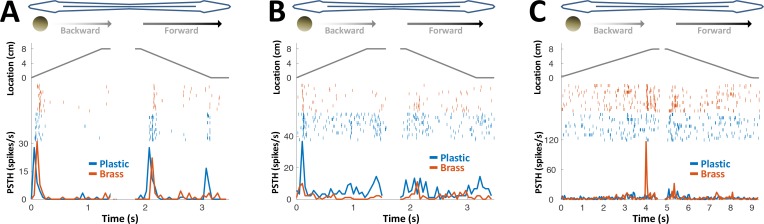
PG response to conductive/non-conductive objects.(A–C) Top: object location (distance from the tip of the nose) during longitudinal object motion; middle: spike raster; bottom: PSTH. Red: conductive object (brass sphere, mimicking plants and animals); Blue: non-conductive object (plastic sphere, mimicking rocks). (A) Example cell responding to both brass and plastic spheres (such responses were found in 57% of the cells, 24/42). (B) Example cell responding primarily to plastic, with a very faint response to brass (5% of the cells, 2/42). (C) Example cell responding to brass only (38% of the cells, 16/42). The predominance of cells responding to both brass and plastic spheres or to brass-only spheres is likely inherited from OT (Bastian, 1982).